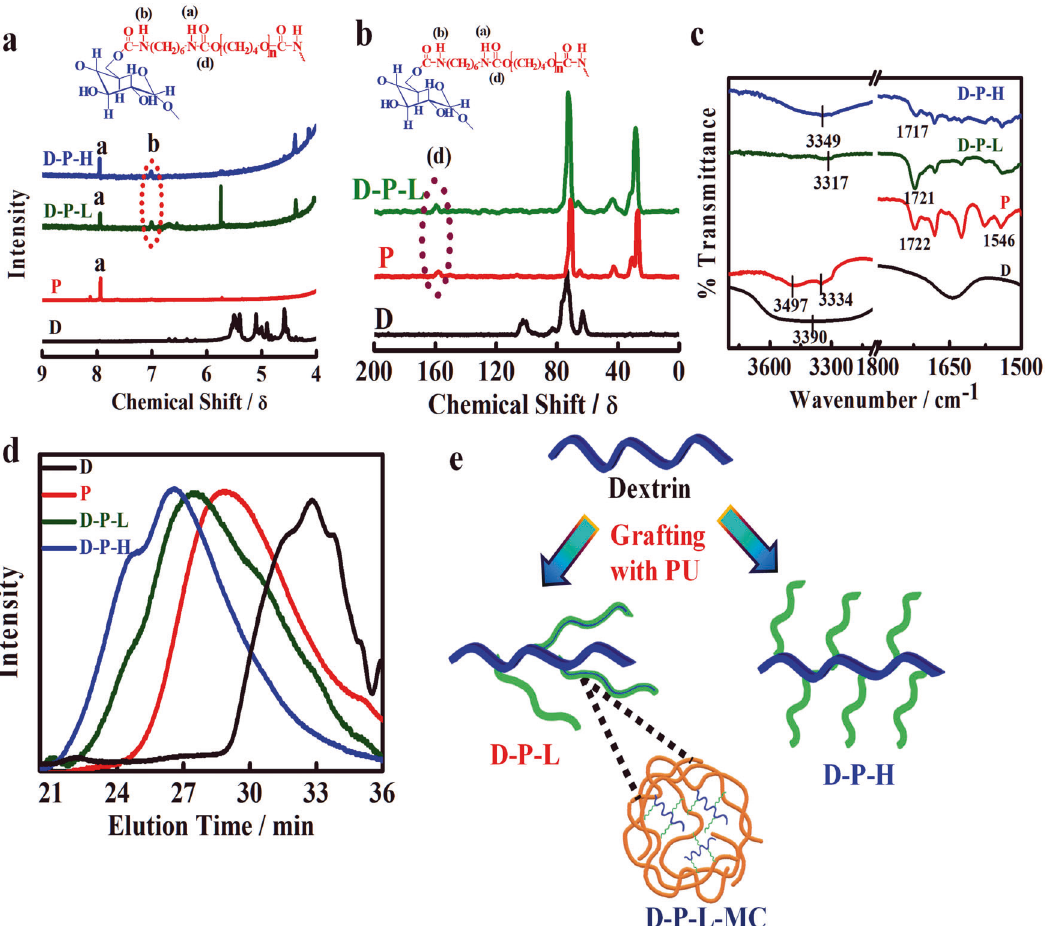
Fig. 1 Veri fi cation of grafting and interactions between polymeric chains. a 1 H NMR Spectra of linear dextrin (D), polyurethane prepolymer (P) and their indicated grafts showing the change of hydrogen bonding as presented marked by ‘ a ’ and the new peak position due to grafting marked by ‘ b ’ and other NMR peaks information are given in Supplementary information. b 13 C NMR spectra of D, P, and their indicated grafts showing the new peak arising from graft reaction. c FTIR spectra of pure dextrin, prepolymer, and their graft copolymers showing shifting in peak positions due to interactions. d Gel permeation chromatograms of pure dextrin and its indicated grafts, where high graft density copolymers elute at a lower time. e Schematic models showing preparation to two graft density brushes from dextrin and its embedment in methyl cellulose to form injectable hydrogel